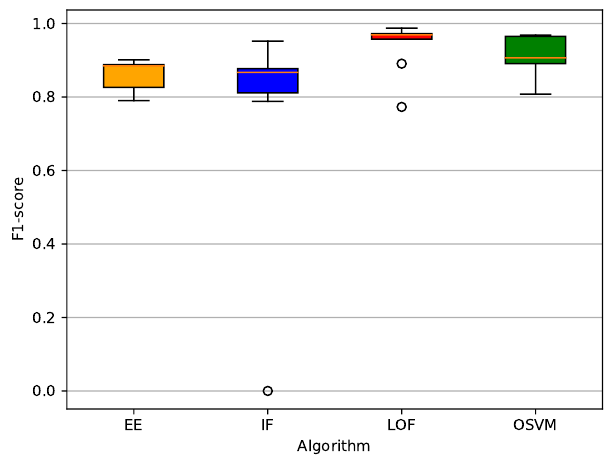
Figure 5. F1-scores considering all datasets with optimised parameters.